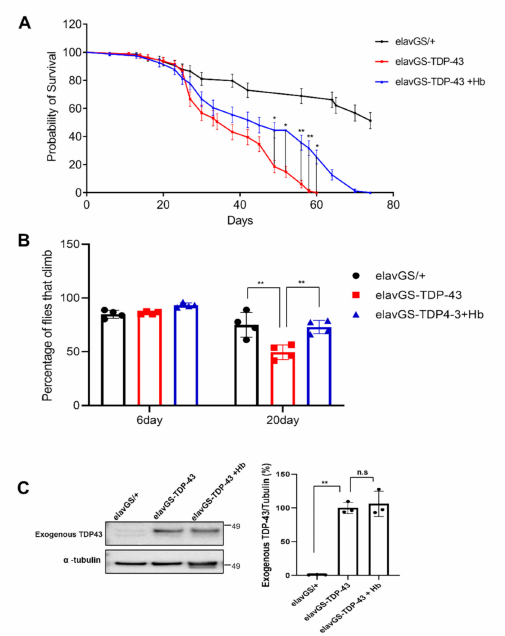
Figure 7. Hydroxocobalamin mitigates TDP-43-induced neuronal toxicity in a Drosophila model. Lifespan ( A ) and climbing ability ( B ) of elavGS-TDP-43 + DMSO or elavGS-TDP-43 + Hb flies at the indicated time points. The TDP-43-induced motility deficit was significantly rescued by treatment with Hb (10 µ M). Quantification of the percentage of flies that survived and climbed. Data are presented as the means ± SEM of four independent experiments. * p < 0.05, ** p < 0.01 (one-way ANOVA followed by Tukey’s multiple comparison test). ( C ) Immunoblot analysis of TDP-43 proteins from head lysates of control or TDP-43-expressing flies. α -Tubulin was used for normalization. Data are presented as the means ± SEM. n.s., not significant (one-way ANOVA followed by Tukey’s multiple comparison